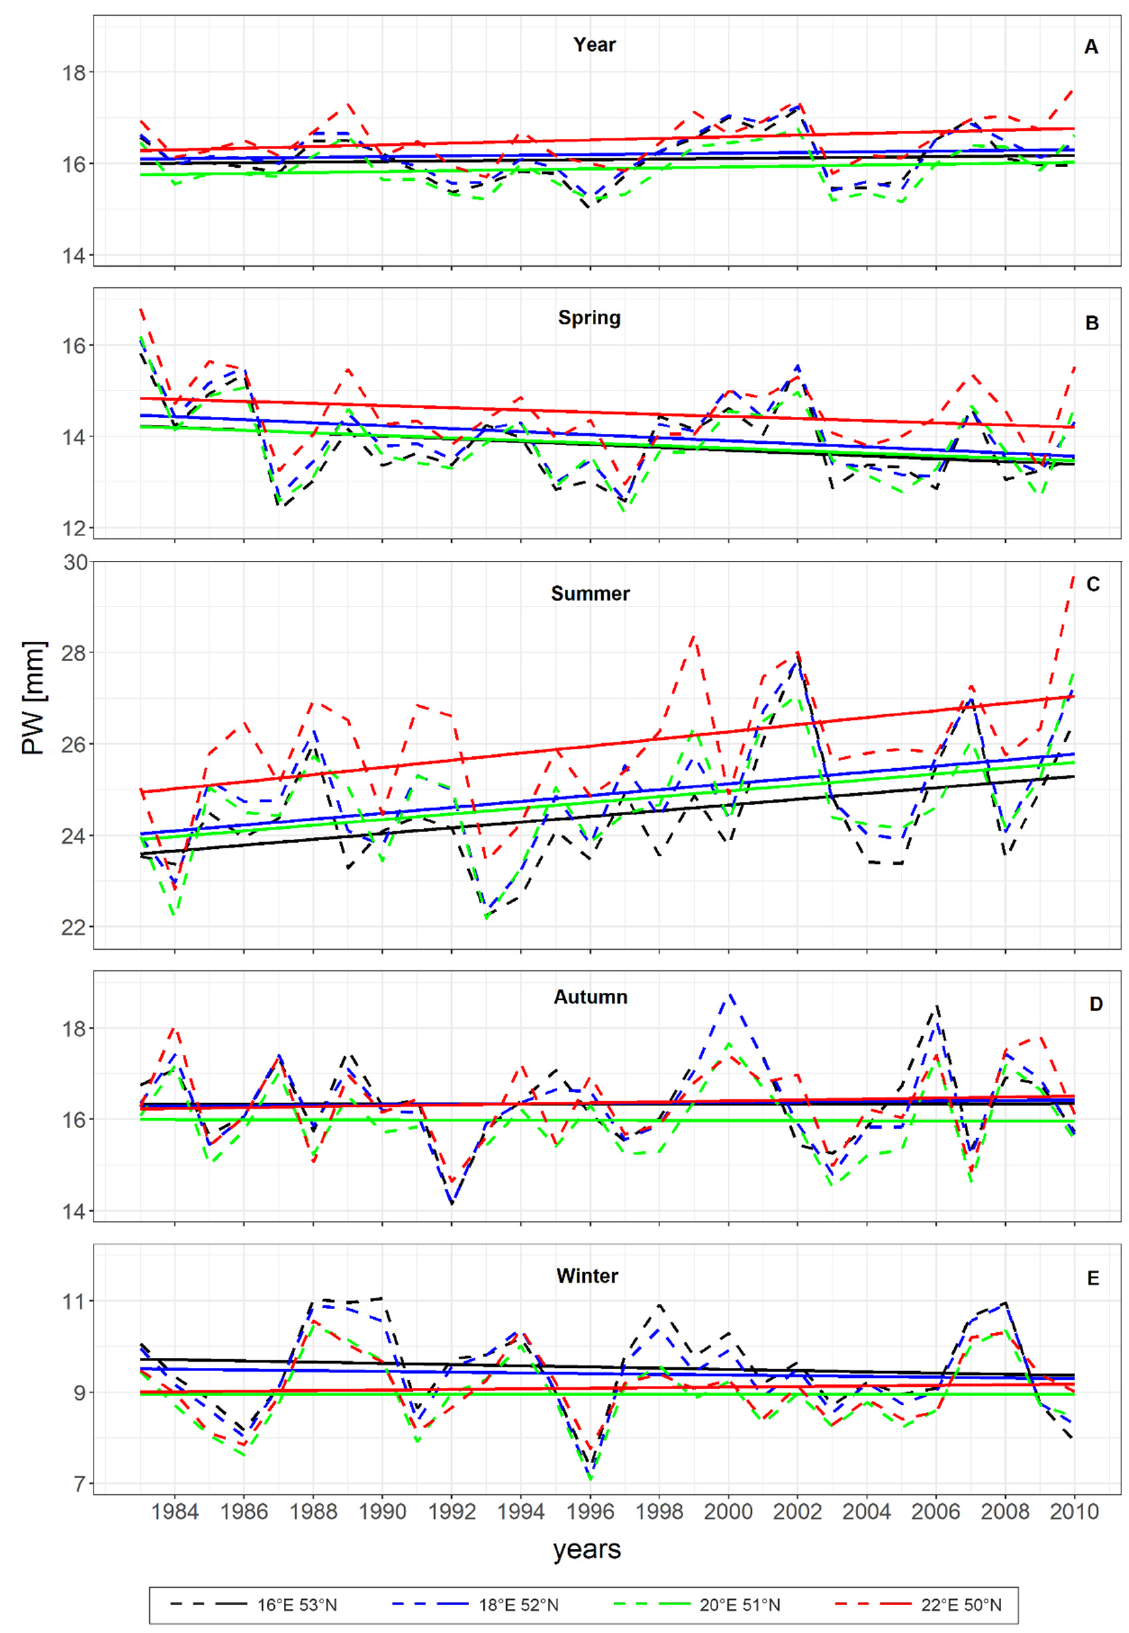
Figure 12. Annual ( A ) and seasonal ( B – E ) PW (dashed lines) with trend lines (solid lines) for selected grid points from the years 1983–2010.